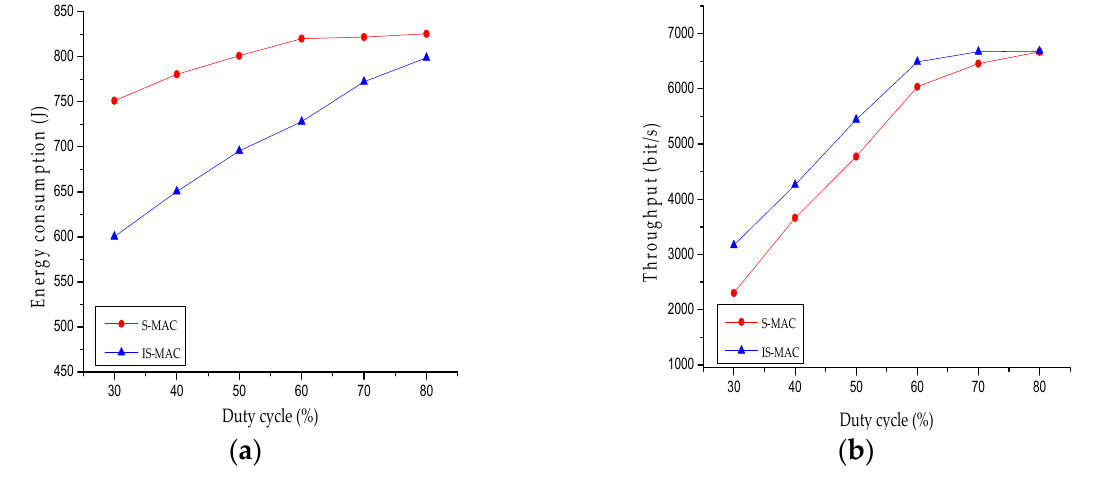
Table 2. Network parameters.